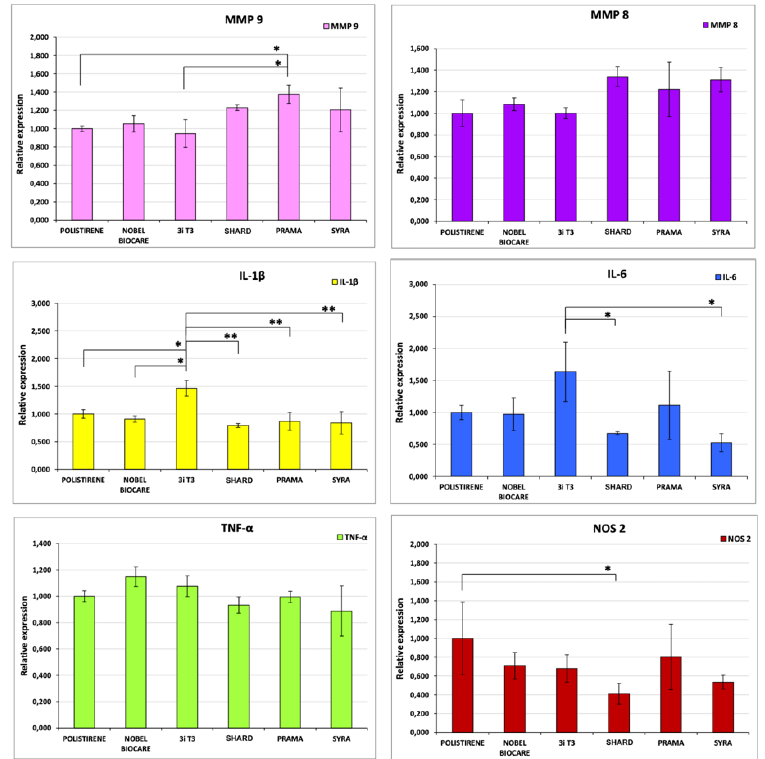
Figure 2. Outcomes of the statistical analysis of gene expression data for each sample for each gene analyzed. Samples presenting a statistically significant difference in gene expression are indicated with *. * p < 0.05, ** p < 0.01. Results are expressed as Mean (SD), n = 3.